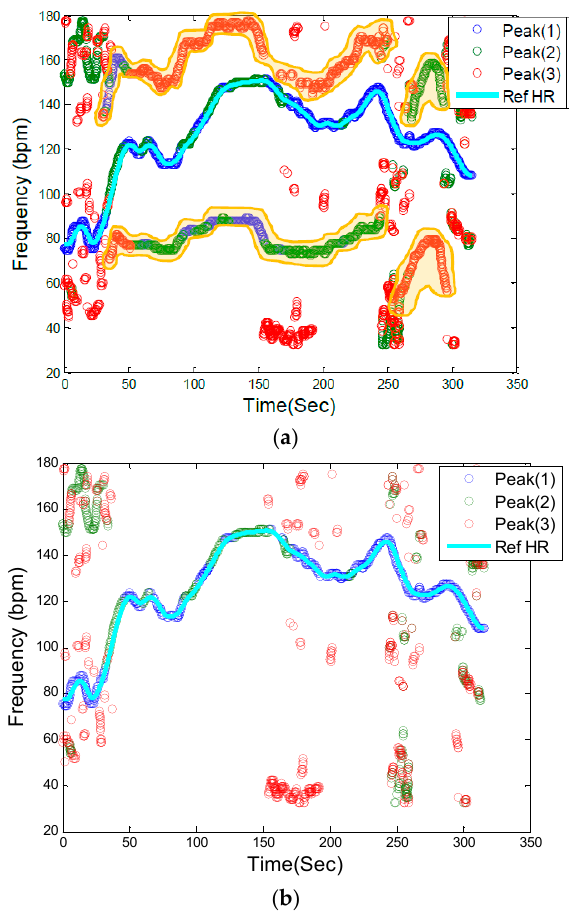
Figure 3. Motion artifact detection in the PPG spectrum. ( a ) Filtered PPG spectrum with movement and HR components: Shaded yellow elements (A, B, C, D) represent motion frequency components in the PPG spectrum, and the light blue line is the reference HR from clean reference ECG signal, ( b ) Filtered PPG spectrum after removing motion artifact frequency components.